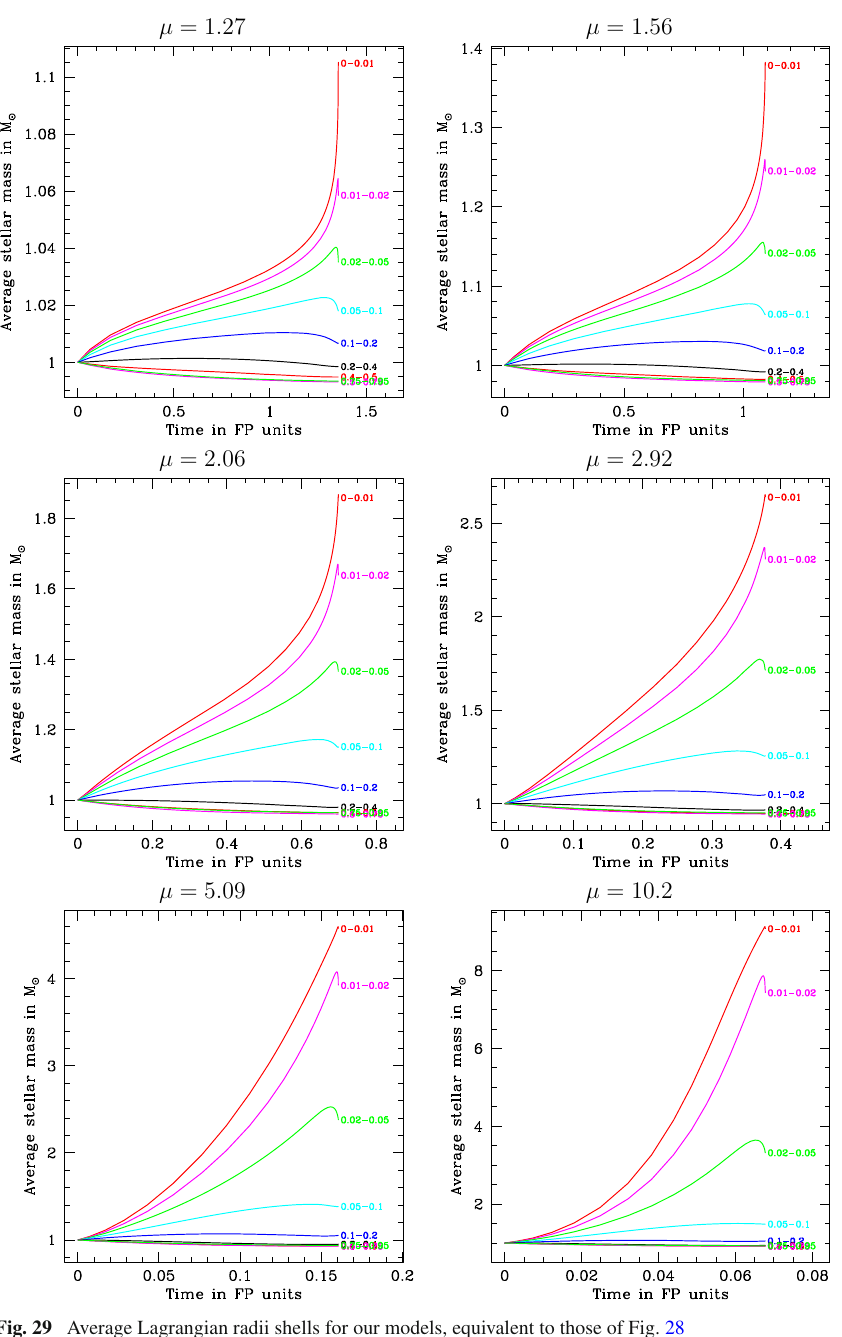
Fig. 29 Average Lagrangian radii shells for our models, equivalent to those of Fig.